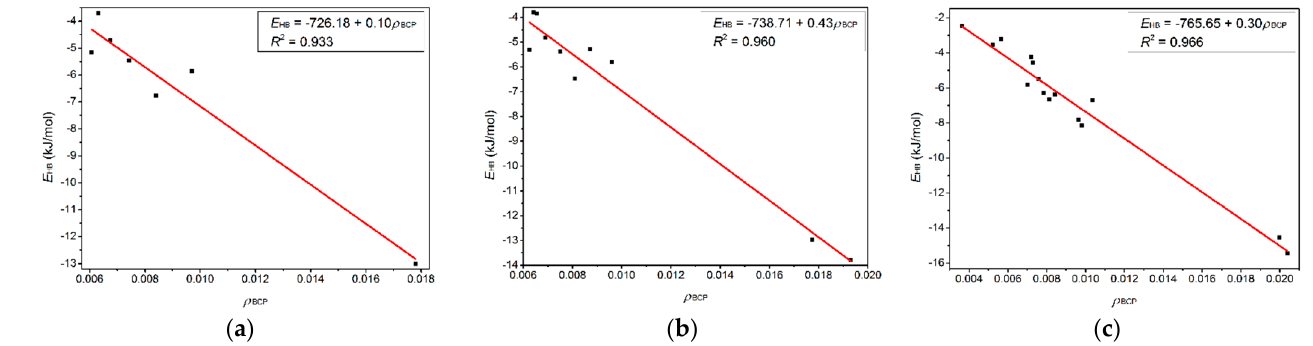
Figure 7. Correlations variation of the hydrogen bond energy ( E HB , kJ/mol) with the electron density at BCPs ( ρ BCP , a.u.) for the microhydrates, ( a ) T-3H 2 O-[C 6 mim] + -Br − -1, ( b ) T-2H 2 O-[C 6 mim] + -2Br − -1, and ( c ) T-1H 2 O-2[C 6 mim] + -2Br − -1.